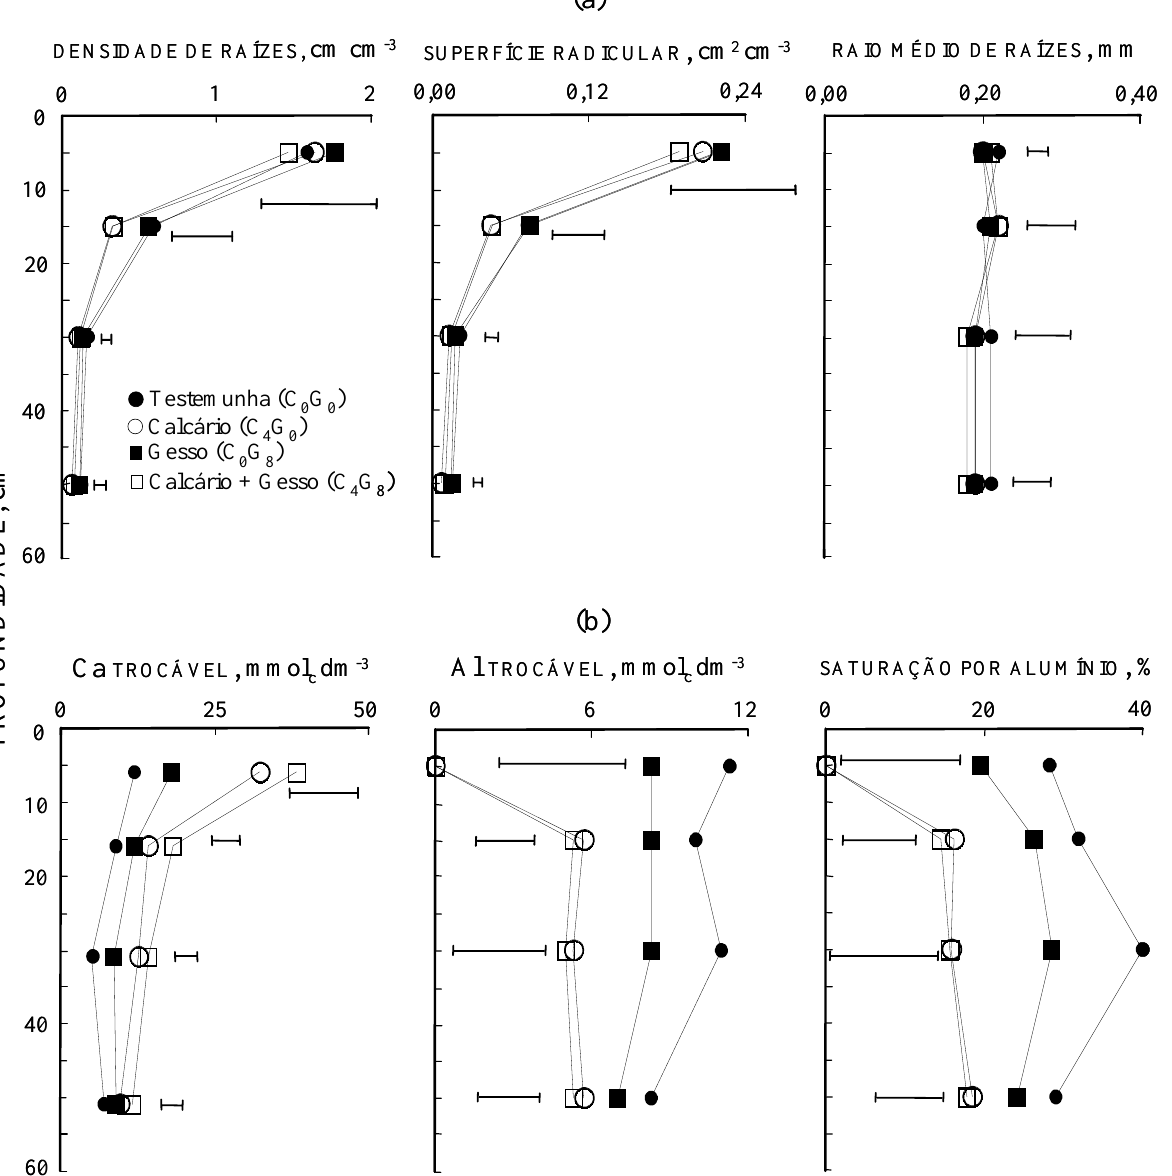
Figura 1. Efeito da calagem e aplicação de gesso nas características de crescimento de raízes de soja (a) e em atributos da fertilidade do solo (b), considerando a profundidade. Barras horizontais indicam o DMS pelo teste de Tukey a